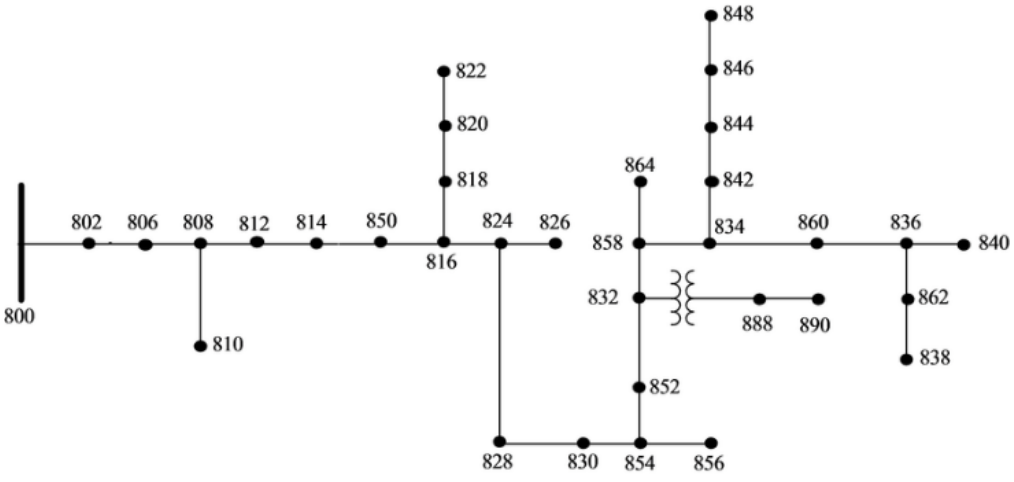
Figure 2. IEEE34 Bus Feeder Layout. Table 1. IEEE34bus Model Steady State Data Comparison.